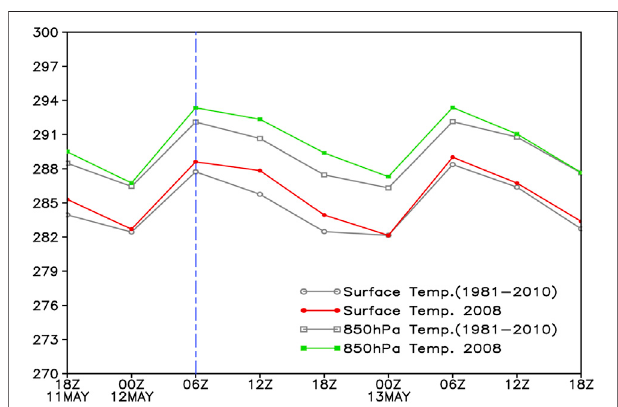
FIGURE 7 | Mean distribution of temperature (units: K) in the seismic area around the earthquake. The blue dashed line denotes the occurrence time of the earthquake.